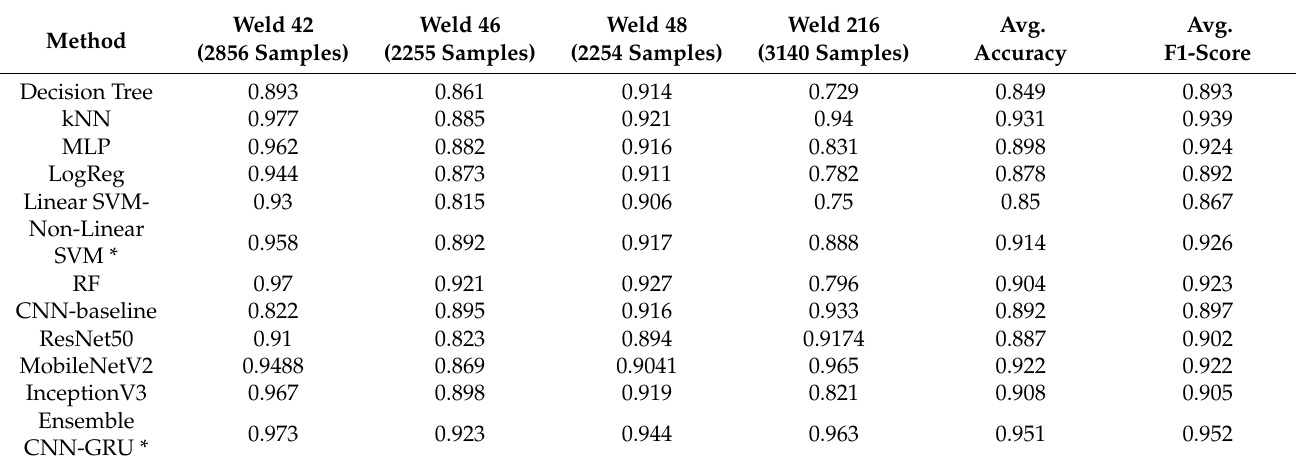
Table 5. Classification performance for different welding trials (not within the training data set).